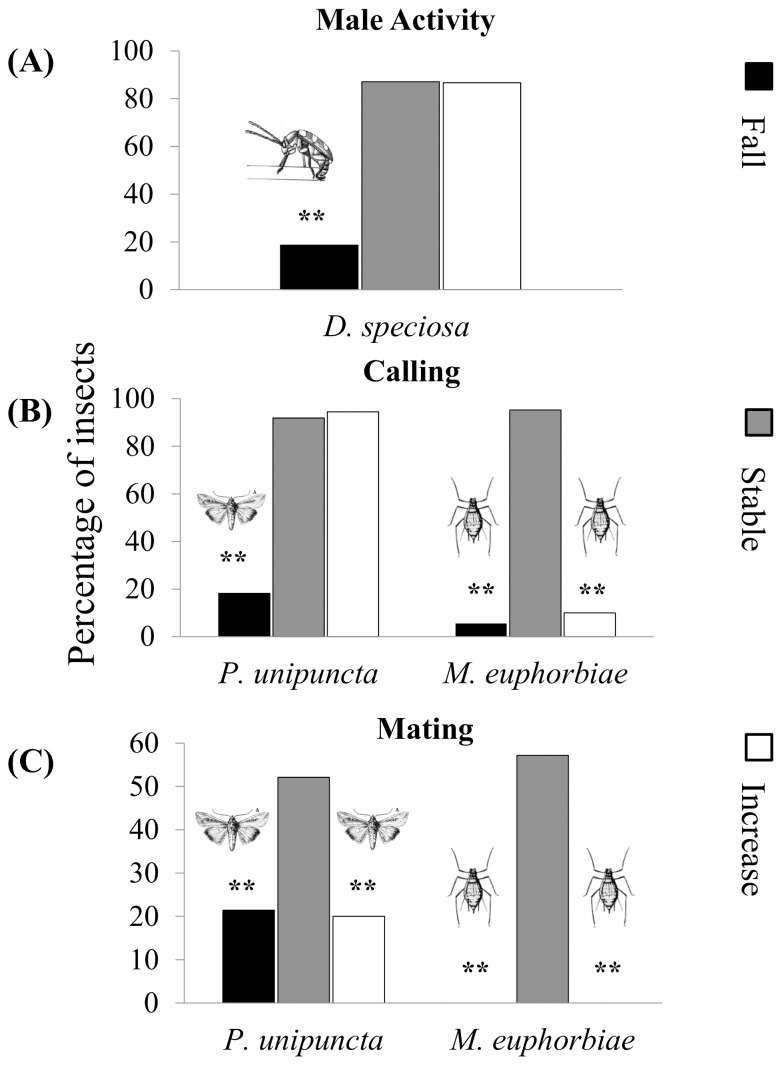
Insect Behaviour under different barometric pressure conditions.Frequency of different behaviours exhibited by three different insect species when subjected to stable, decreasing and increasing barometric pressure. A: The proportion of active D. speciosa males in Y-tube olfactometer to sex pheromone stimuli; B: The proportion of P. unipuncta and M. euphorbiae females exhibiting calling behaviour; C: The proportion of P. unipuncta and M. euphorbiae couples mating. **Indicates significant difference among treatments at 1%.